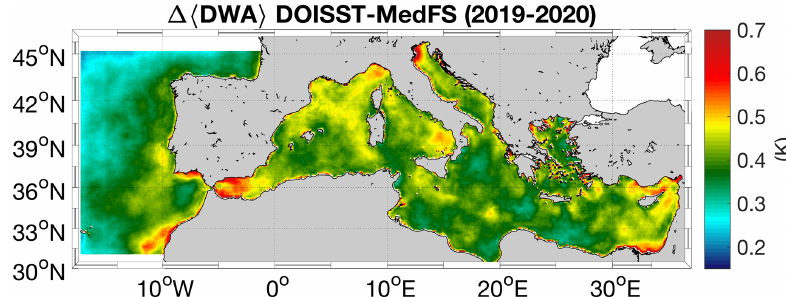
Figure 9. Mean amplitude of the SST DW. Differences between the mean DWA seen by DOISST and